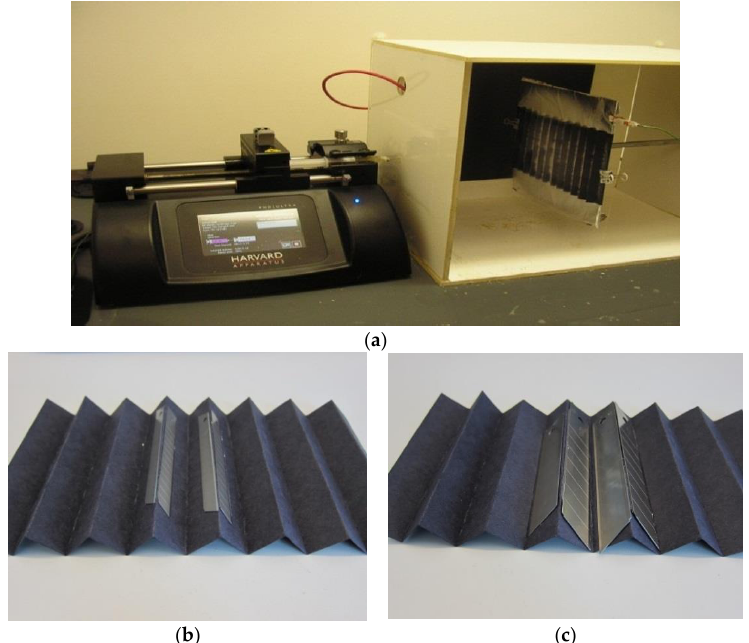
Figure 1. ( a ): A photograph of the experimental set-up used for electrospinning nanofibrous 2-D and three-dimensional (3-D) structures, V-shaped cardboard collectors showing the placings of the grounded metal blades: 1 ( b ) of 5 mm width, ( c ) of 10 mm width.